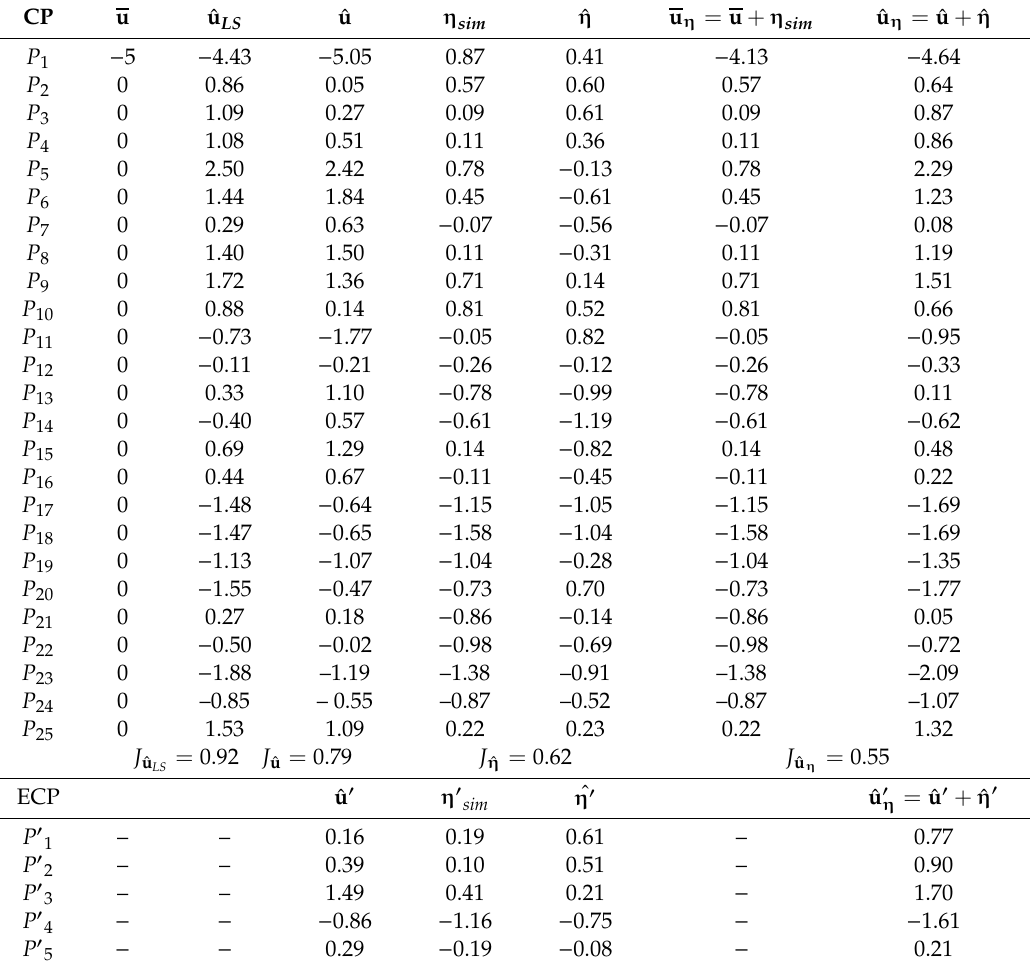
Table 2. The results of estimation and prediction (in mm) for the simulated free control network